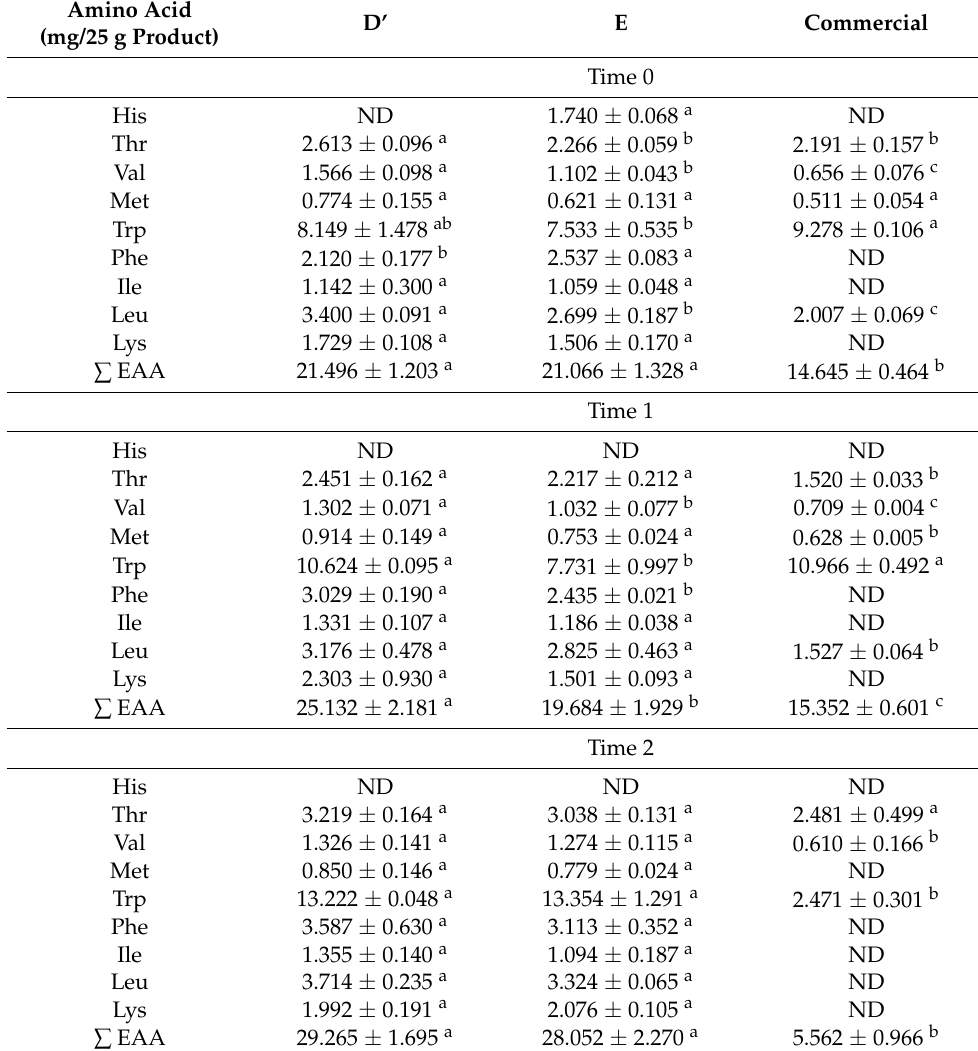
Table 3. Essential amino acid profile for E, D’ and Commercial low-fat mayonnaises. Amino